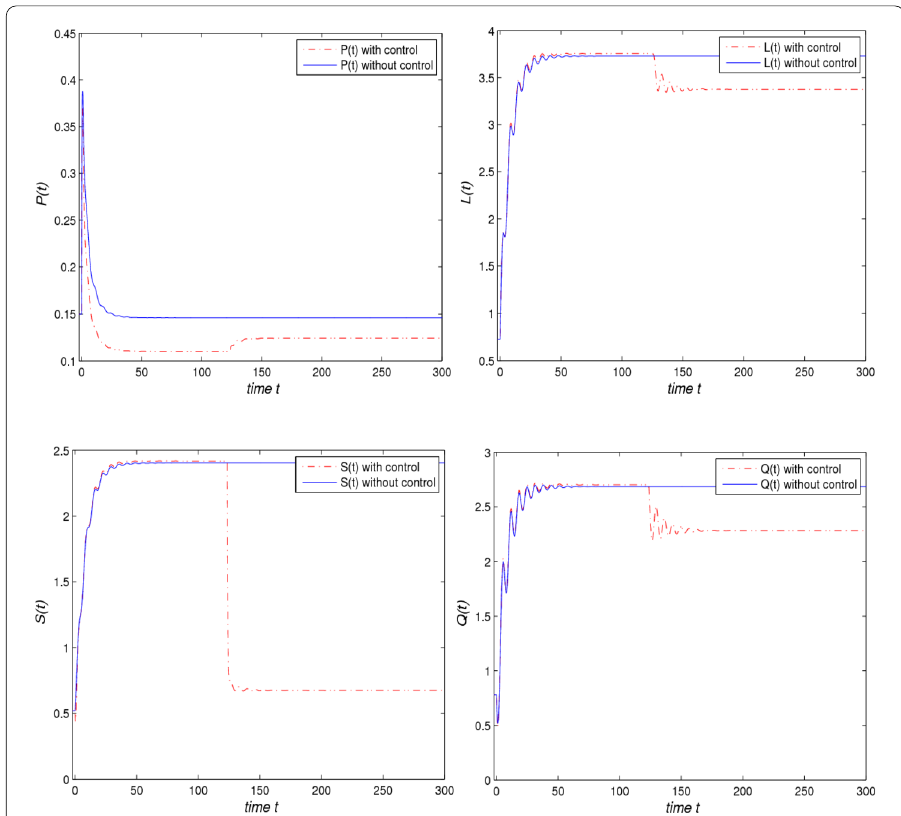
Figure 10 The behavior time plots of P , L , S and